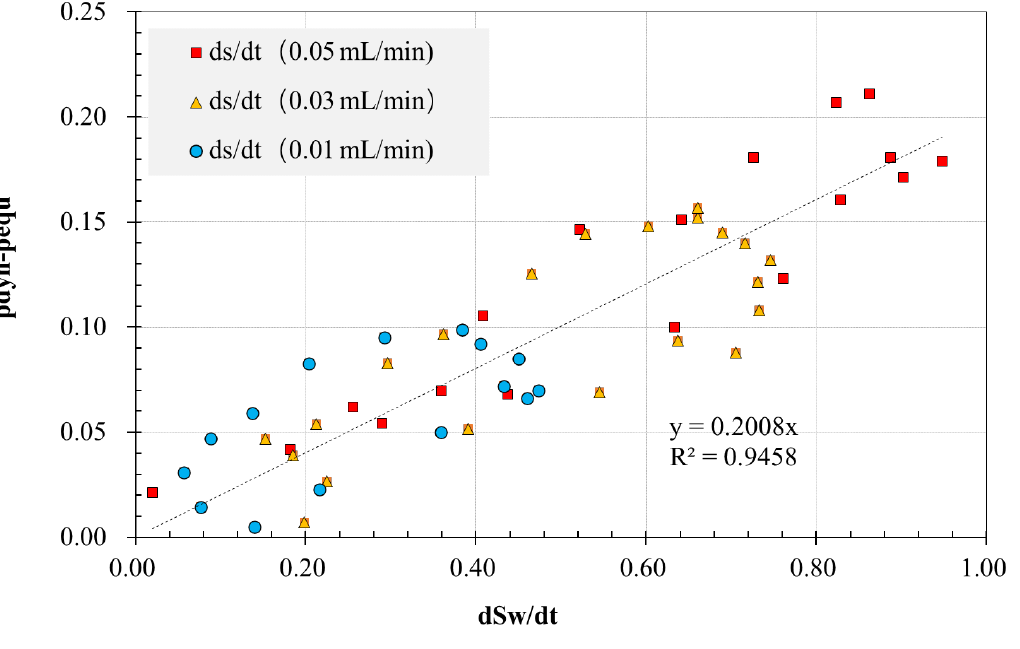
Figure 3. Linear fitting of experimental data.